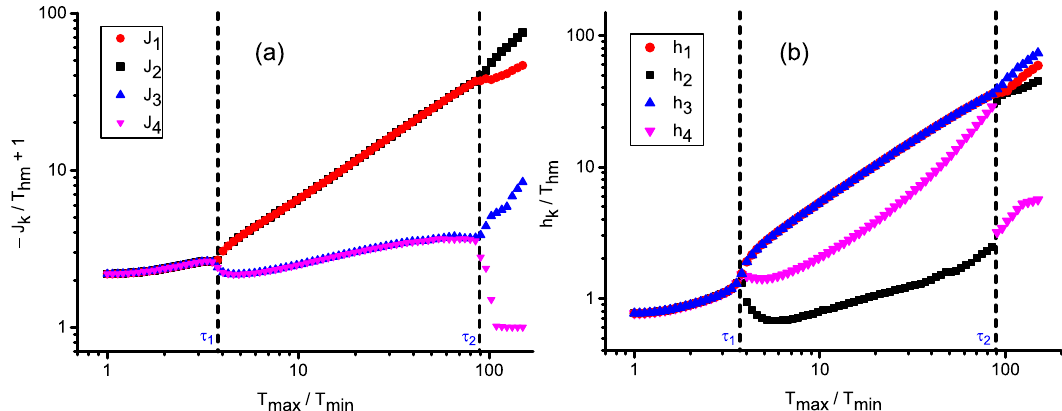
Fig. 2 Optimal probe for the non-uniform XYZ Hamiltonian. Optimal parameters against temperature ratio T max = T min for an optimized H XYZ (reduced to an Ising model) for n = 4 spins. a ZZ-coupling strengths J k between the k th and ( k + 1)th spin ( k = 1, 2, 3, 4). For illustration purposes, we plot − J k shifted positively by 1 unit. b External magnetic fi elds, with strength h k acting on the k th spin. The parameters are scaled with the characteristic temperature T hm , where T hm is the harmonic mean of T min and T max . The dashed lines indicate the onset of the splitting of optimal parameters.